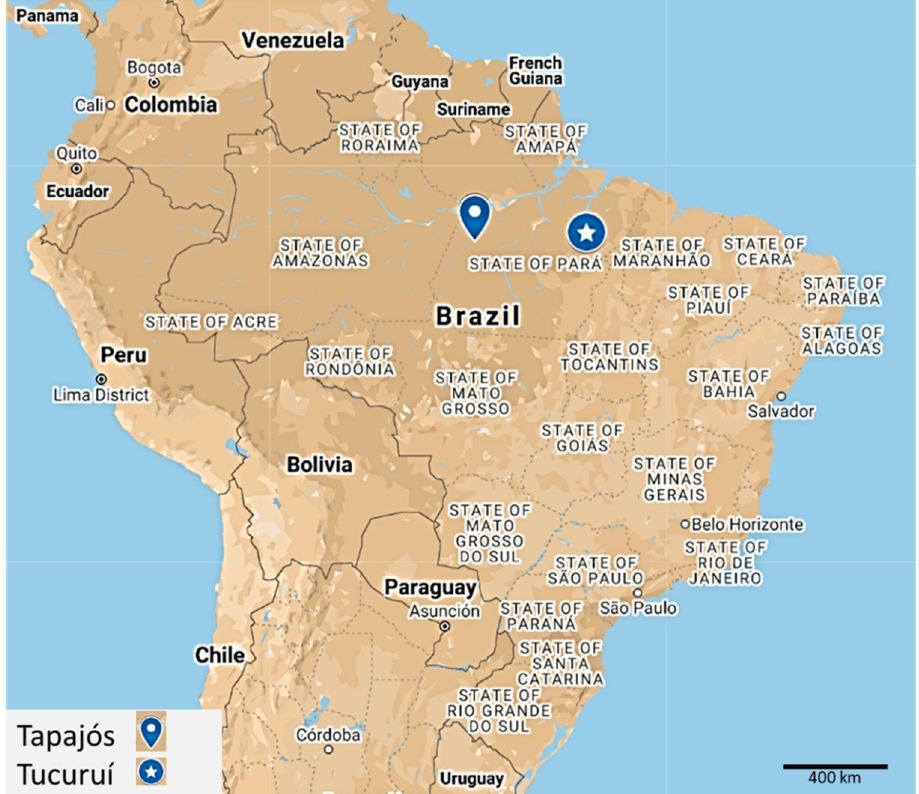
Figure 1. Map of the States of Brazil with the approximate locations of the two regions where individuals were enrolled for this study: The Tapajós River basin and the Tucuruí Lake. This map was designed using MyMaps of Google and it can be consulted at: https://www.google.com/maps/d/u/0/edit?mid=1u0_9V0_jI_RYzJ1Ed1n2UM1apLe4tH7Z&usp=sharing (accessed on 1 August 2021).